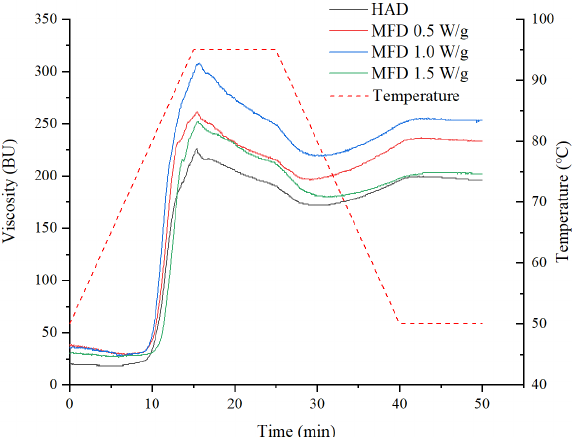
Figure 5. Viscosity–temperature profiles of yam flours prepared by HAD and MFD.